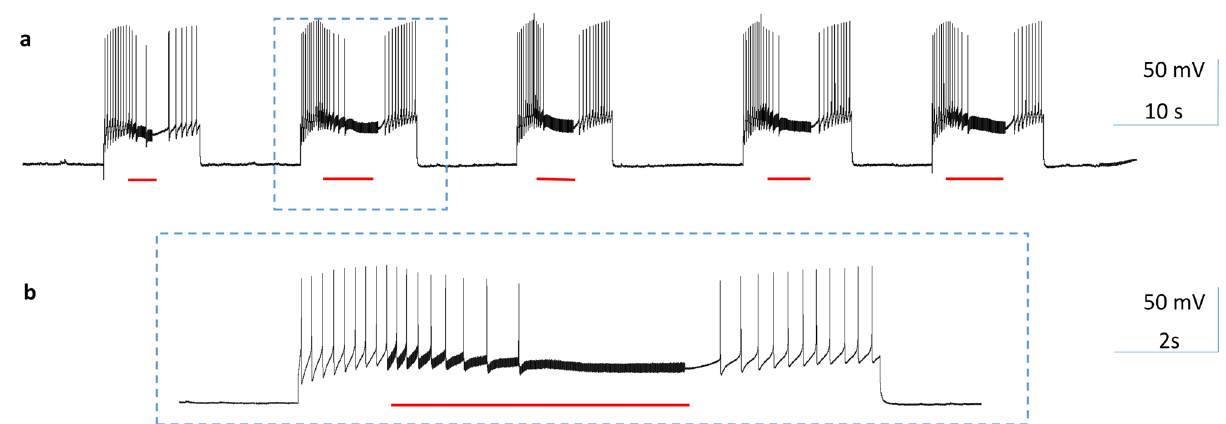
Figure 4. High-frequency magnetic stimulation inhibited buccal ganglion neurons firing at a high rate. Position of the miniature coil was as in Fig. 3a. ( a ) A depolarization current was injected into the soma of the B3 neuron to elicit a train of high frequency (5–7 Hz) action potentials for approximately 10 s. Magnetic stimulation reversibly blocked these action potentials. ( b ) Expanded traces in ( a